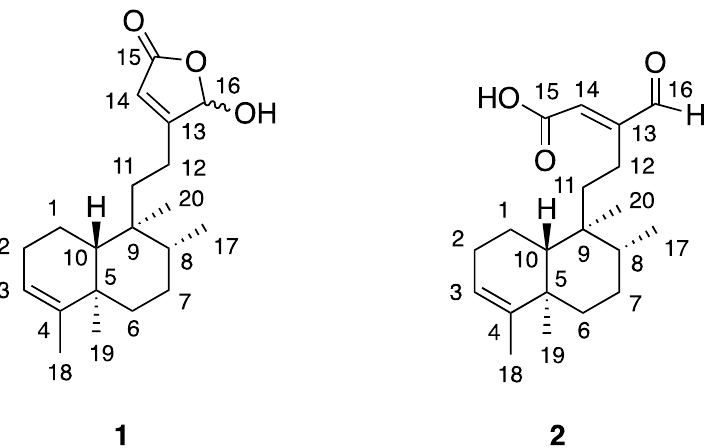
Figure 1. Chemical structure of compound 1 , 16( α / β )-hydroxy-cleroda-3,13 (14) Z -dien-15,16-olide,